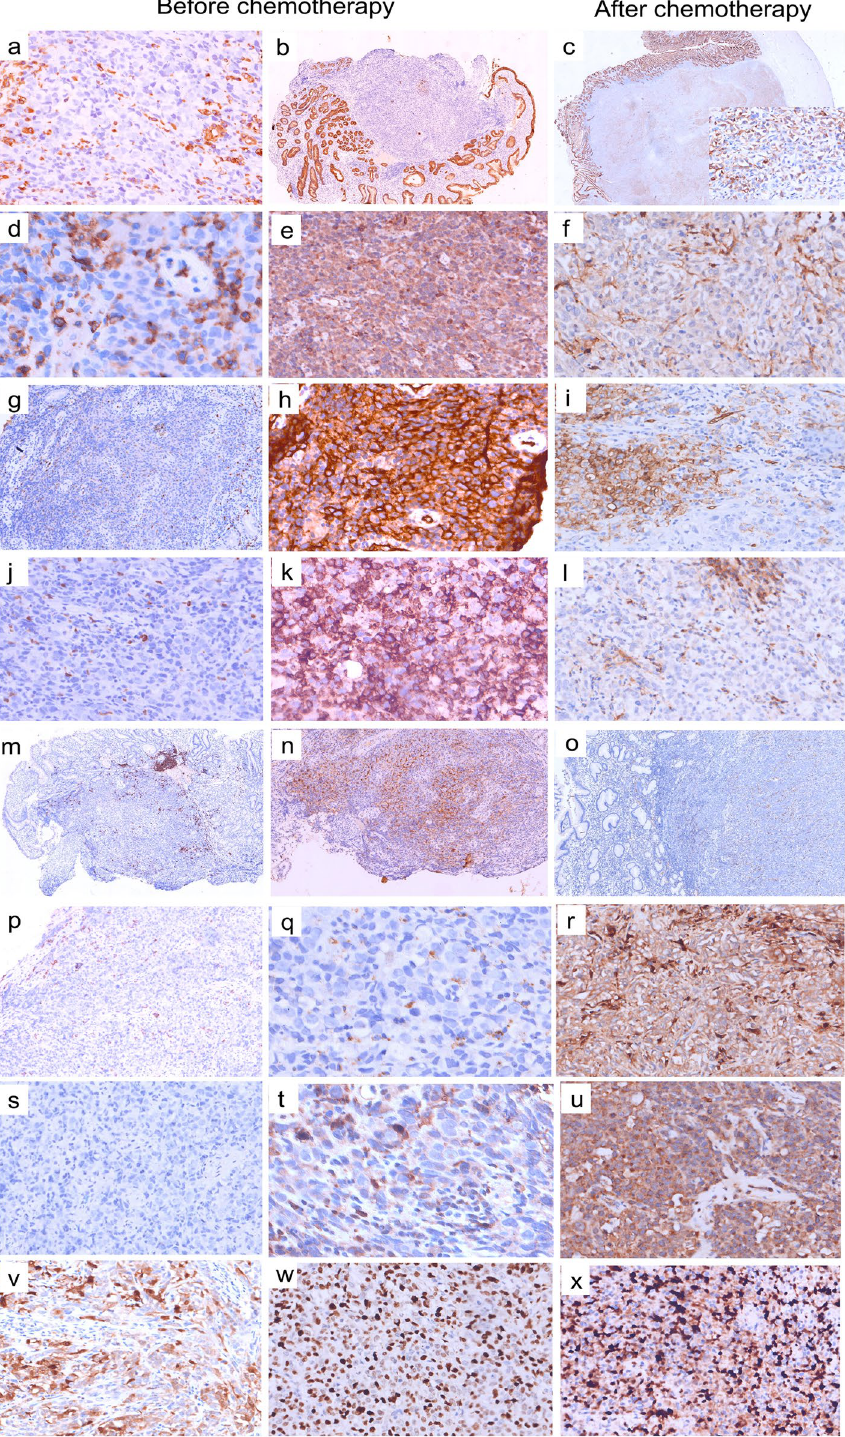
Fig. 3 Comparison of preoperative and postoperative histopathology and immunohistochemistry. a Vimentin: negative ( from negative to positive